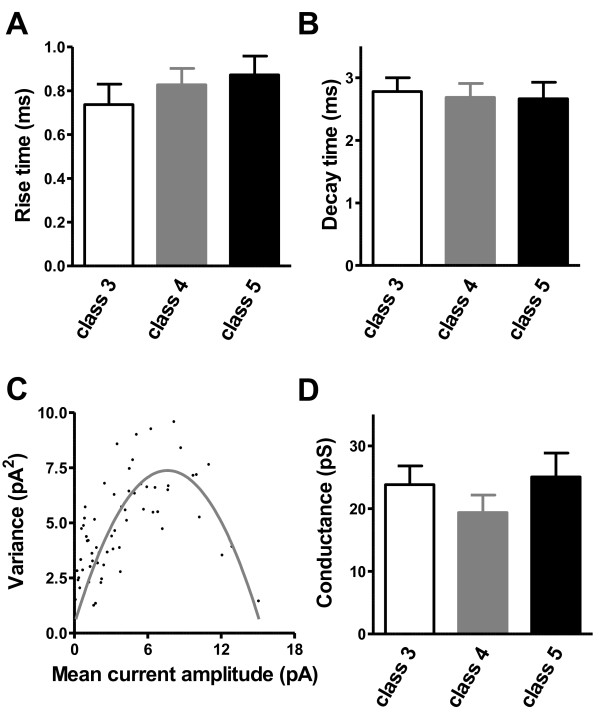
AMPAR-mediated EPSCs during maturation of adult-generated GCs. (A) The 10-90% rise time of AMPAR-mediated EPSCs did not differ between different stages of maturation (class 3: eleven slices, eleven mice; class 4: sixteen slices, fourteen mice; class 5: nine slices, seven mice). (B) Similar decay time constants were observed for the different classes of developing adult newborn GCs (class 3: seven slices, seven mice; class 4: ten slices, nine mice; class 5: nine slices, seven mice). (C) Variance-mean current relationship from peak-scaled non-stationary fluctuation analysis. Gray line shows a parabolic relationship. (D) Estimated single open channel conductance for AMPARs. Fluctuation analysis did not show any significant change in AMPAR channel conductance during maturation (class 3: seven slices, seven mice; class 4: twelve slices, eleven mice; class 5: nine slices, seven mice).